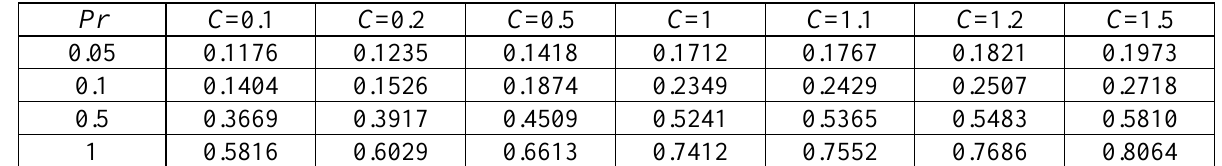
¢- with C and Pr ( K =1, B =0.1).